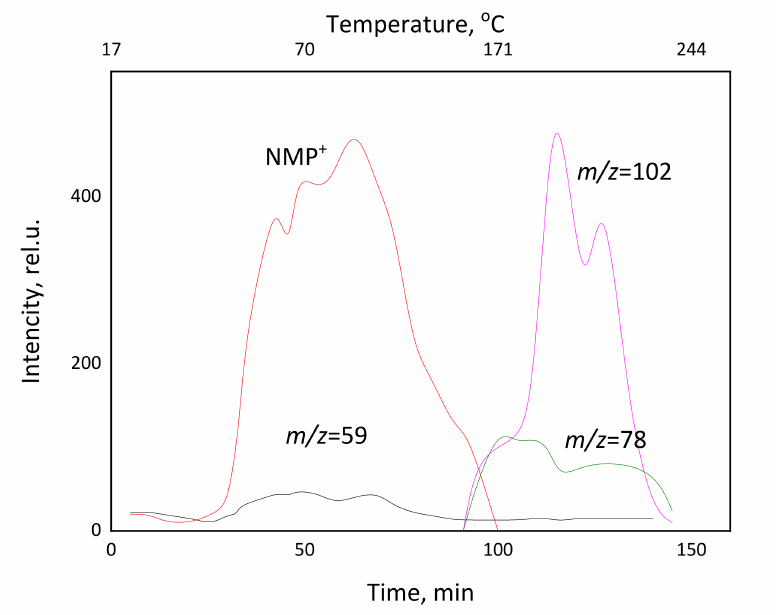
Figure 5. Temperature- and time-dependences of intensities of ion currents for Torlon/DES-10. From the data obtained by TGA and mass spectrometric analysis, it follows that DES loading does not affect the thermal stability of the membranes. The evaporation of residual solvent (NMP) begins from both pure Torlon and the Torlon/DES composite at about 130 ◦ C, according to the obtained data. The evaporation of the most volatile component of DES, acetamide, occurs almost simultaneously. This follows from the fact that the weight loss in this range of the TG curve of Torlon/DES is approximately 6% higher compared to the pure film. Meanwhile, the mass spectra of the vapor composition over the modified membrane exhibit peaks corresponding to the ionization of acetamide. Polymer thermal destruction for both membranes begins at 360 ◦ C. The second component of DES, ZnCl 2 , evaporates at higher temperatures (~700 ◦ C) [37,38], which are beyond the investigated temperature